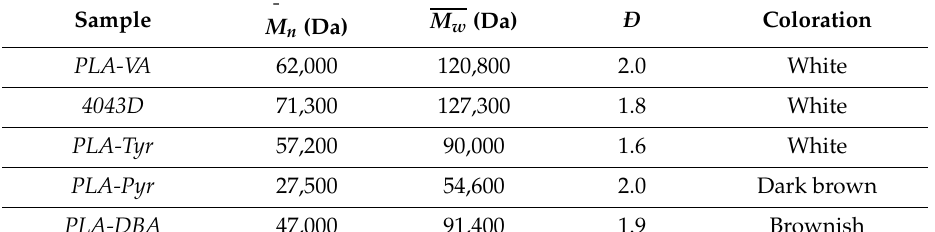
Table 2. Molecular weight data (PS equivalents) according to SEC.